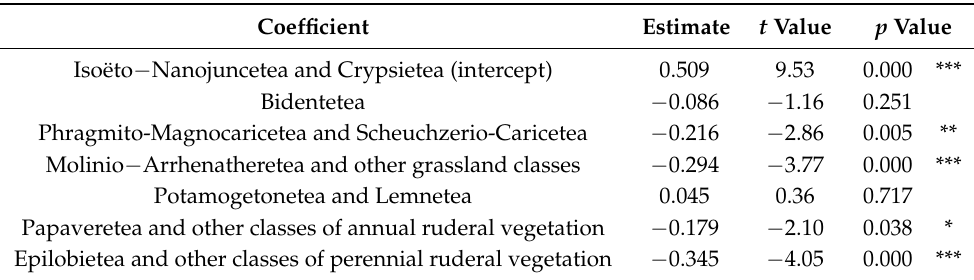
Table 3. Linear model of the proportion of occurrence in the soil depending on the belonging of species to one of seven groups according to phytosociological classes. Isoëto-Nanojuncetea and Crypsietea species serve as reference. The estimate of the other groups indicates the deviation from the reference. Significance codes: * <0.050; ** <0.010; ***